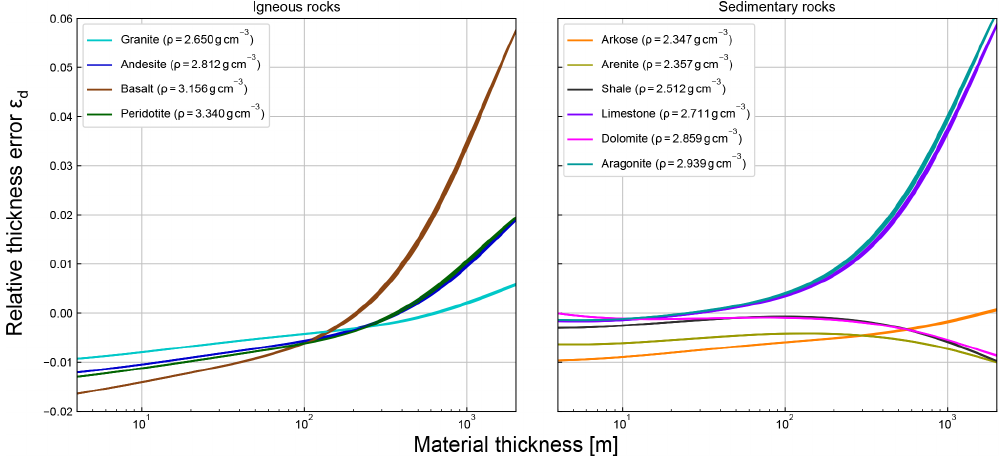
Figure 8. Relative error which is made in the thickness estimation of a block of rock by assuming a density-modified standard rock vs. the actual rock